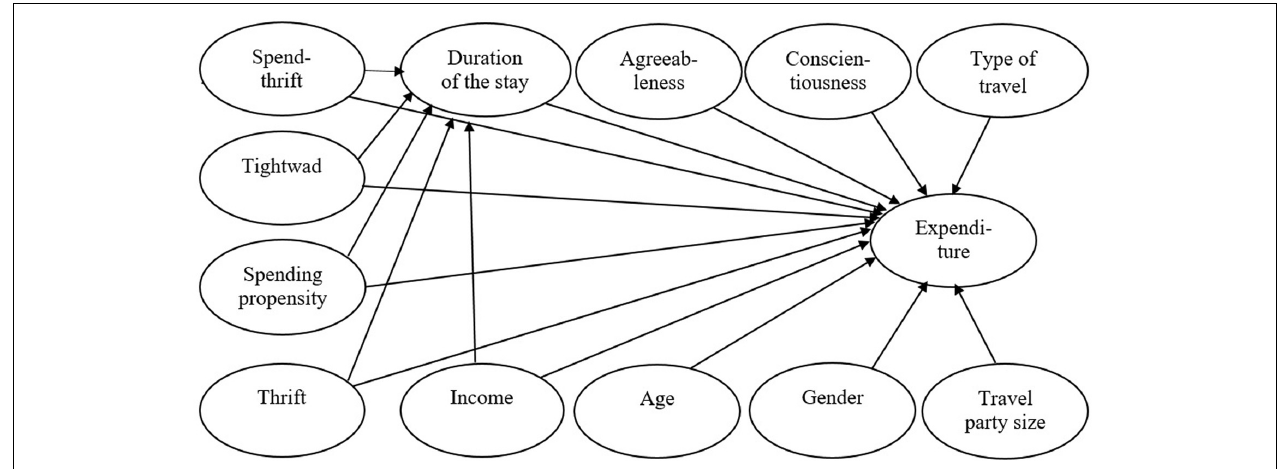
FIGURE 1 | Path model under